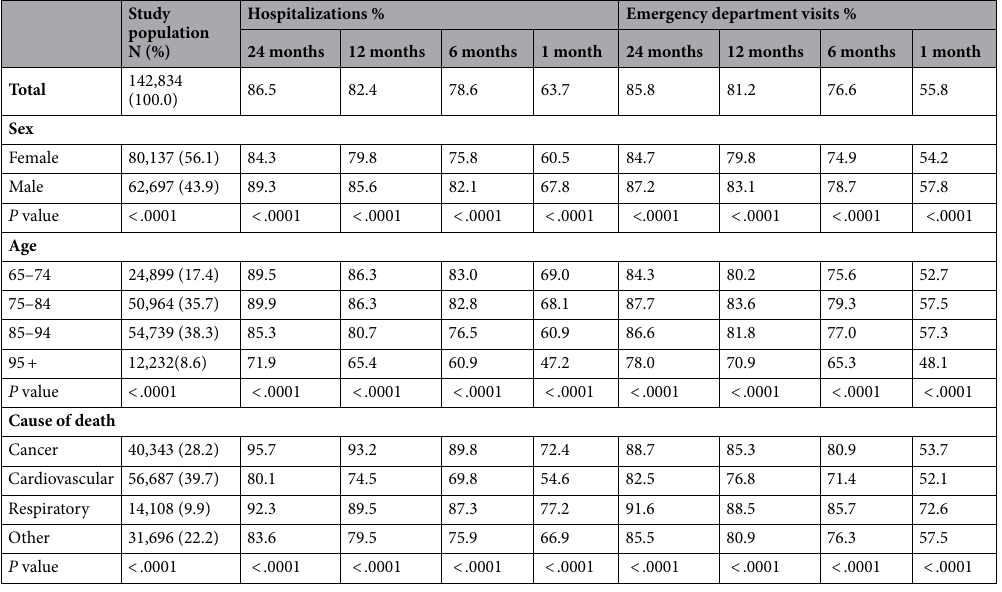
Table 1. Study population size and proportion of individuals who were hospitalized and had accessed the emergency department 24, 12, 6, and 1 month before